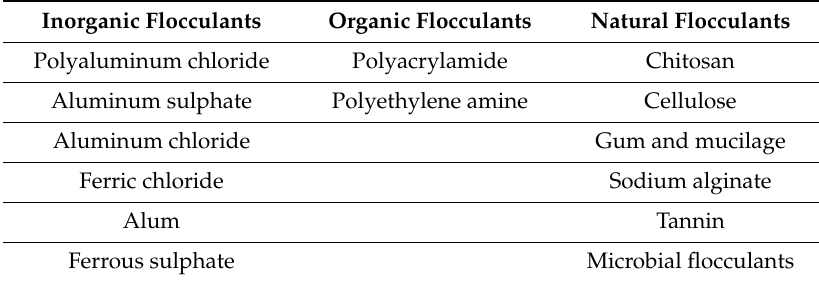
Table 1. Classes of